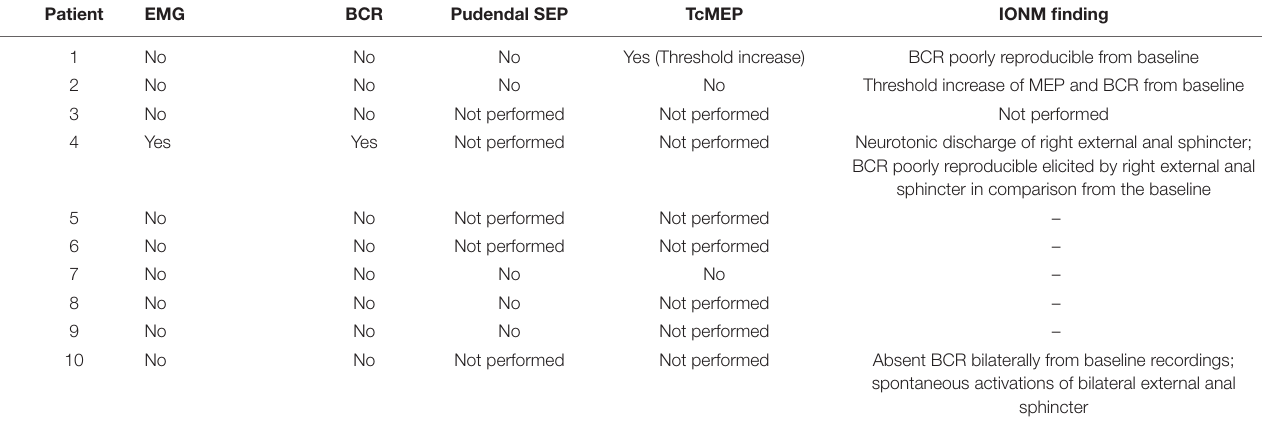
TABLE 2 | Neurophsiological findings: assessment of significant alteration for several intraoperative neuromonitoring (IONM) techniques.